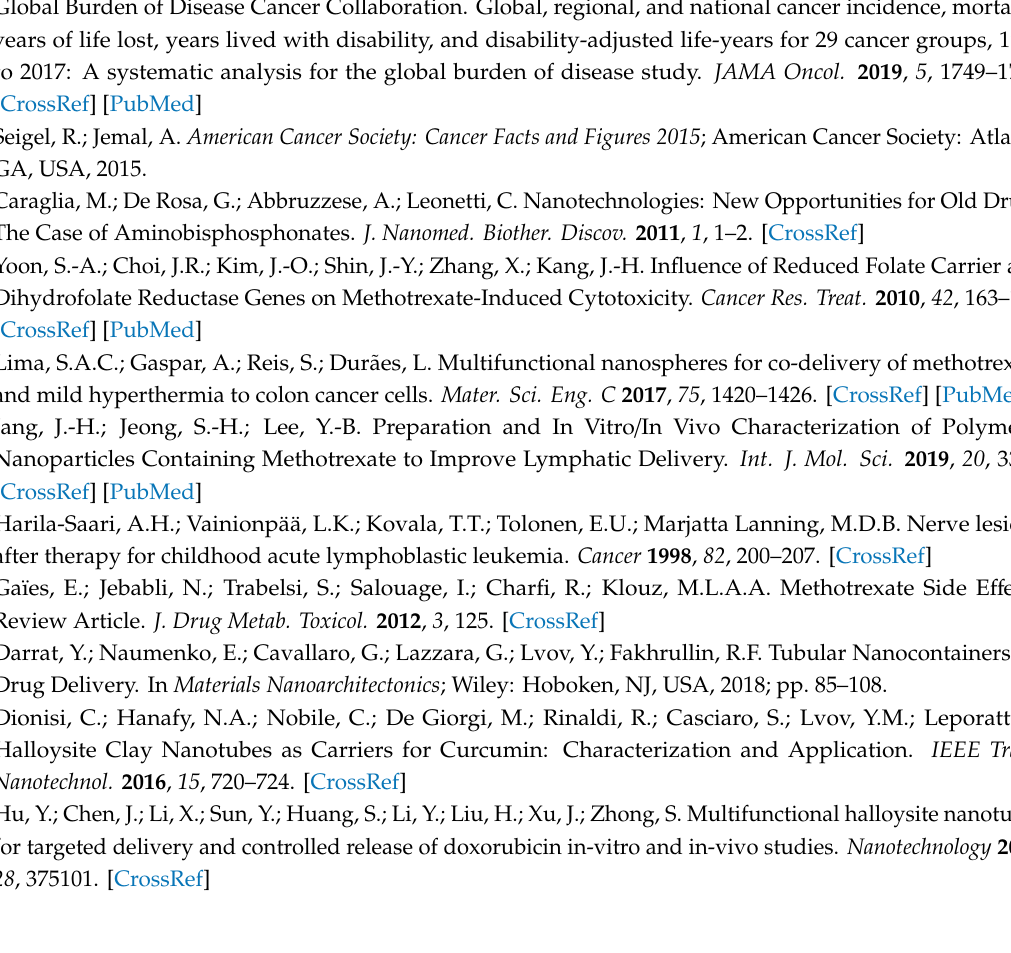
Figure S1: A. Flow cytometer observation of each treatment. B. The selected dot were continued applied with FITC filter for apoptosis (first row) and PE filter for necrosis (second